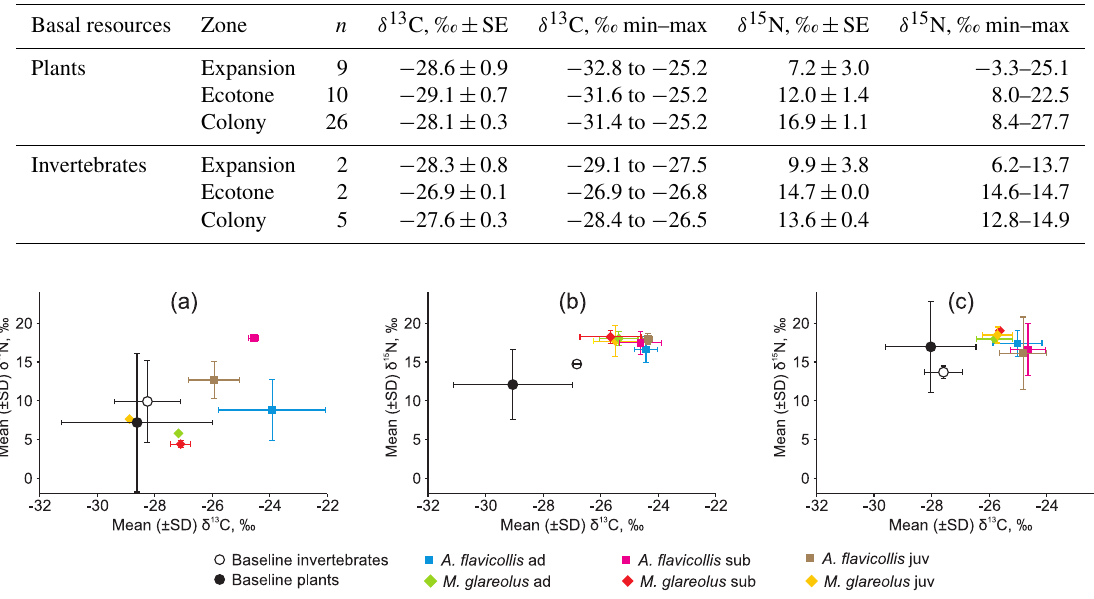
Figure 2. Isotopic signatures of potential animal and plant foods compared with isotopic signatures in the hair of age groups of Apodemus flavicollis and Myodes glareolus , trapped in the expansion (a) and ecotone (b) zones and Juodkrant˙e great cormorant colony (c) in 2015. Ad – adults, sub – subadult animals, juv –